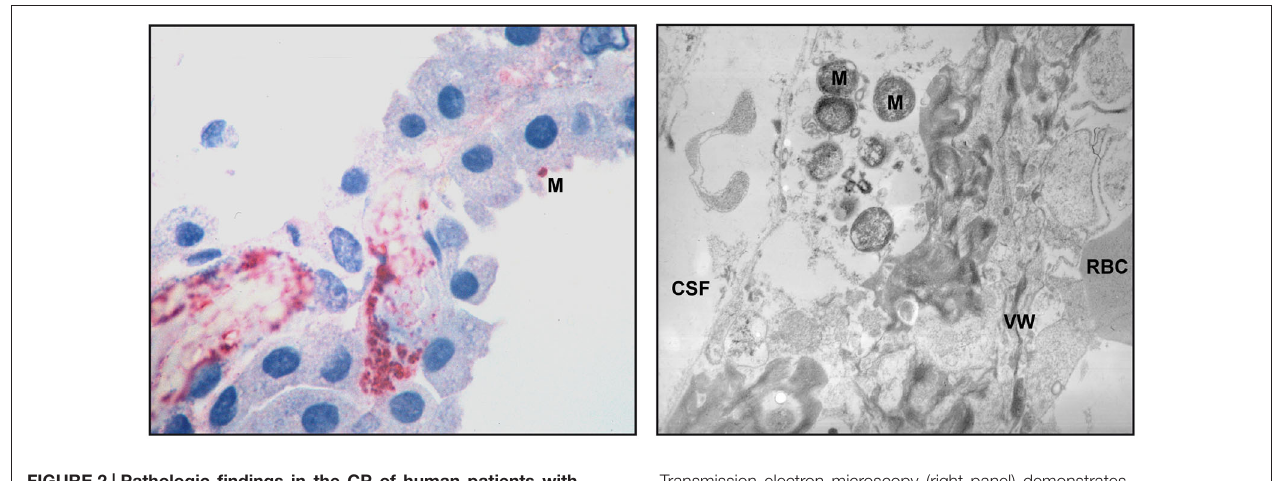
FIGURE 2 | Pathologic findings in the CP of human patients with meningococcal disease . An immunohistochemical examination (left panel) shows abundant bacteria and bacterial antigens in the lumen of a thrombosed blood vessel and in the interstitial tissue. One N. meningitidis organism (M) can be seen in the surface of a CP epithelial cells.